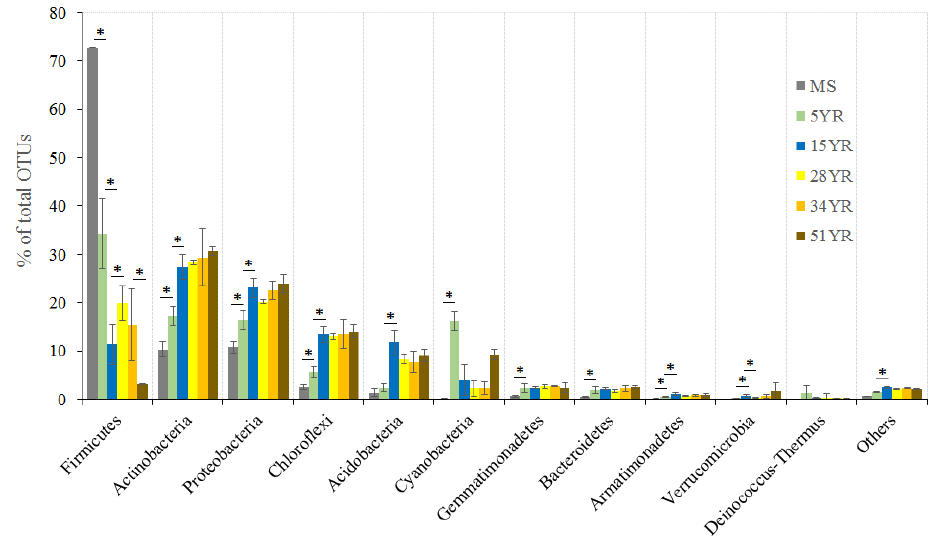
Figure 5. Abundant phyla ( > 10% of total OTUs) and low-abundance phyla (1% < of total OTUs < 10%) of bacteria distributed in different ages of BSCs. Data are defined at a 3% OTU genetic distance. Data are presented as mean ± standard deviation; n = 3 per BSC sample. A paired t test (BSC samples) was used to assess the significance between adjacent ages of BSCs. ∗ P ≤ 0.05; ∗∗ P ≤ 0.001. MS, 5YR, 15YR, 28YR, 34YR and 51YR represent mobile sand, 5-, 15-, 28-, 34- and 51-year-old BSCs, respectively. Table 2. Absolute abundances of bacteria (copies of ribosomal genes per gram of soil) in BSCs quantified by qPCR (means ± standard deviation, n = 6). MS, 5YR, 15YR, 28YR, 34YR and 51YR represent mobile sand, 5-, 15-, 28-, 34- and 51-year-old BSCs, respectively. Dominant MS 5YR 15YR 28YR 34YR 51YR Bacteria abundance 1.12 × 10 6 3.94 × 10 7 2.70 × 10 8 5.44 × 10 8 7.61 × 10 8 9.03 × 10 8 ± 4.19 × 10 5 a ± 2.21 × 10 6 b ± 1.91 × 10 7 c ± 4.23 × 10 7 c ± 8.5 × 10 7 c ± 2.55 × 10 7 c Means with different letters are significantly different ( P < 0 . 05